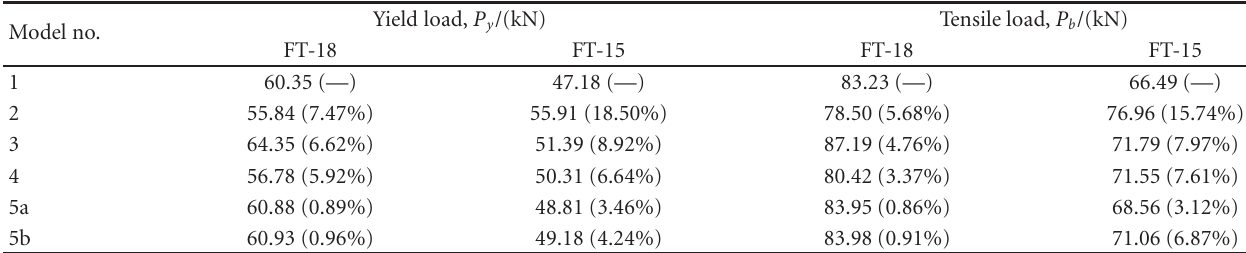
Table 3: Yield and tensile strength predictions of di ff erent SCSM analytical